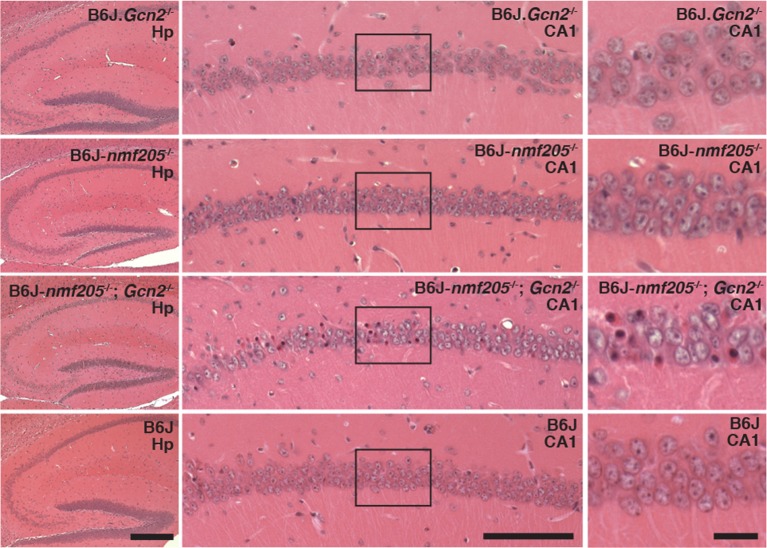
GCN2 protects against loss of B6J-Gtpbp2nmf205-/- CA1 hippocampal neurons.(A) Hematoxylin and eosin stained sagittal sections of 6-week-old B6J.Gcn2-/-, B6J-Gtpbp2nmf205-/- (B6J-nmf205-/-), B6J- Gtpbp2nmf205-/-; Gcn2-/-, and B6J hippocampi. Higher magnification images of hippocampal CA1 are also shown. Scale bars, 250 μm (left panels), 100 μm (middle panels), and 20 μm (right panels).